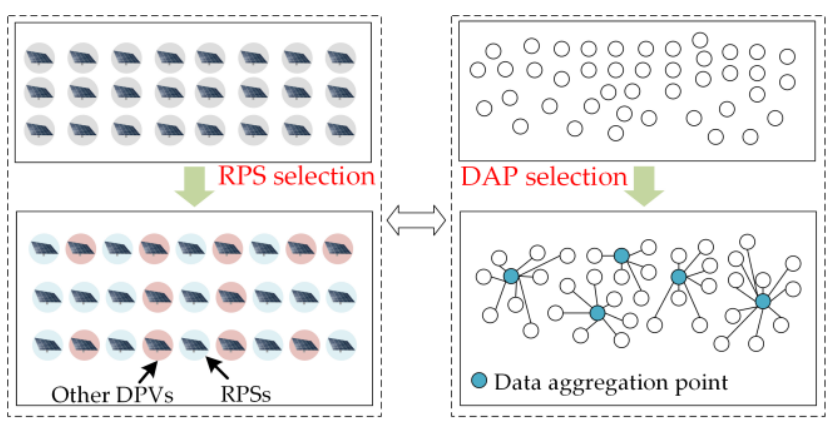
Figure 7. RPS selection and DAP selection process.